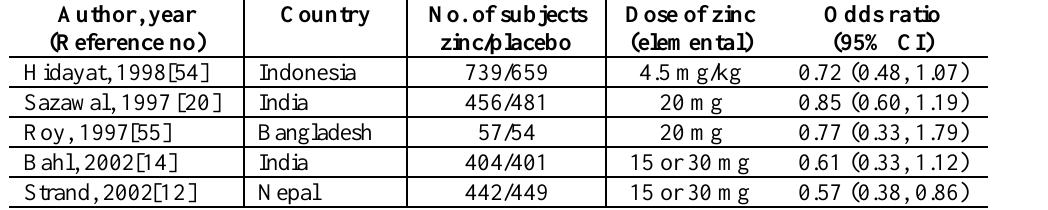
Table III : Studies evaluating therapeutic effects of zinc on episodes of prolonged diarrhea (>7